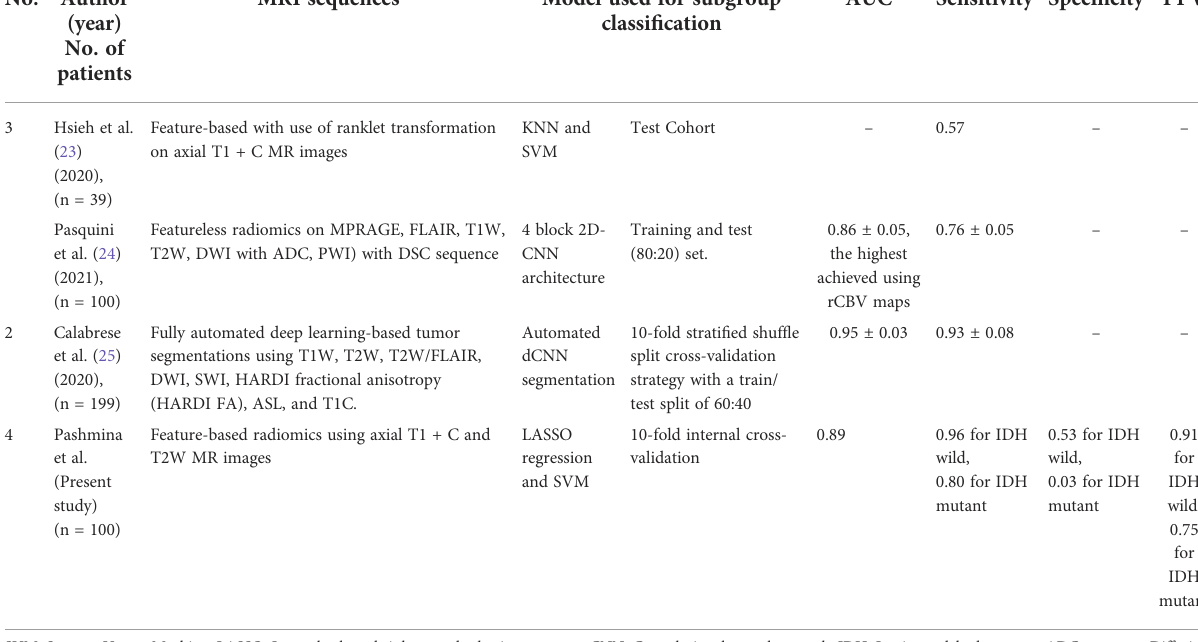
TABLE 7 Literature review of studies using radiomics and or semantic features for glioblastoma molecular subgroup classi fi cation using various diagnostic